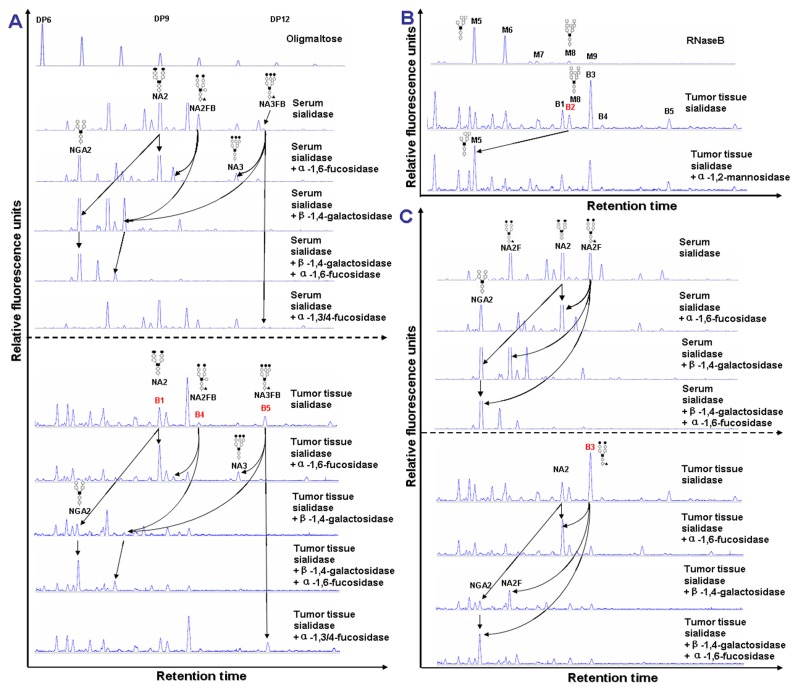
The exoglycosidase sequencing of the membrane protein N-glycans from tumor tissues.(A) Exoglycosidase sequencing of N-glycans of membrane proteins from breast cancer tissue (lower panel) and glycoproteins from healthy human serum as reference (upper panel) to verify the structures of peaks B1, B4 and B5. The structures of peaks B2 and B3 are confirmed in (B) and (C), respectively. The total N-glycans were treated with single or combined exoglycosidase arrays as indicated in context. The arrow lines indicate the changes in glycan peaks that underwent glycosidase digestion. The nomenclature of N-glycans and symbolic representations correspond to those in Figure 2.